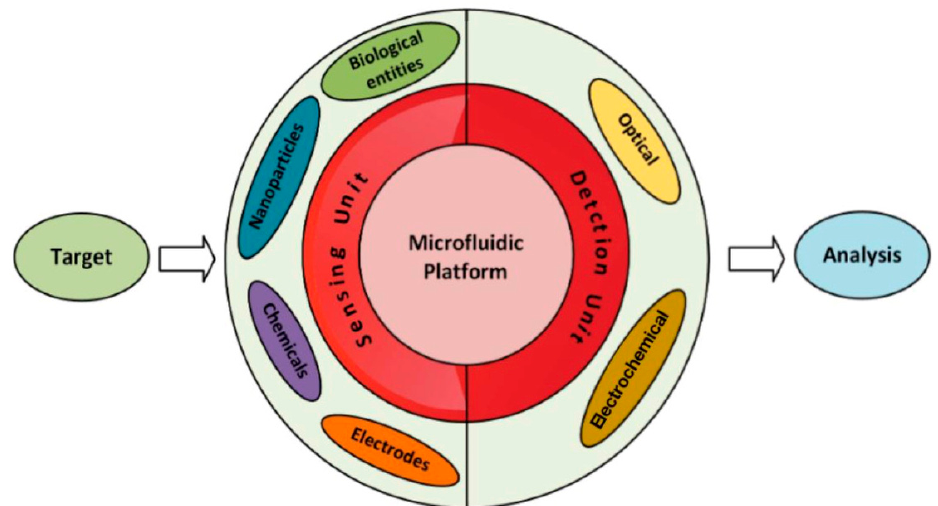
Figure 8. The diagram of a microfluidic sensing system. Reprinted with permission from Ref. [127]. (Copyright, 2019, MDPI).